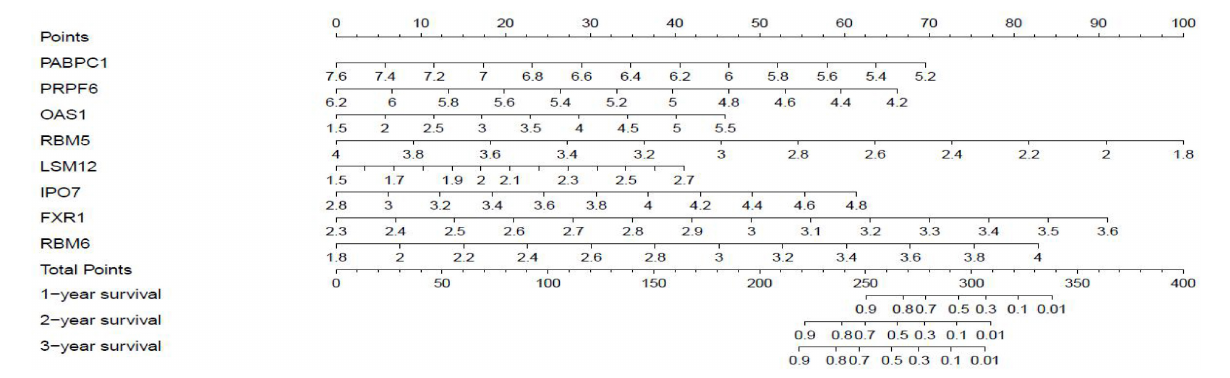
alternative splicing events, leading to cell carcinogenesis ultimately (David and Manley, 2010; Zhang and Manley, 2013). Then, the KEGG pathway enrichment analysis indicated